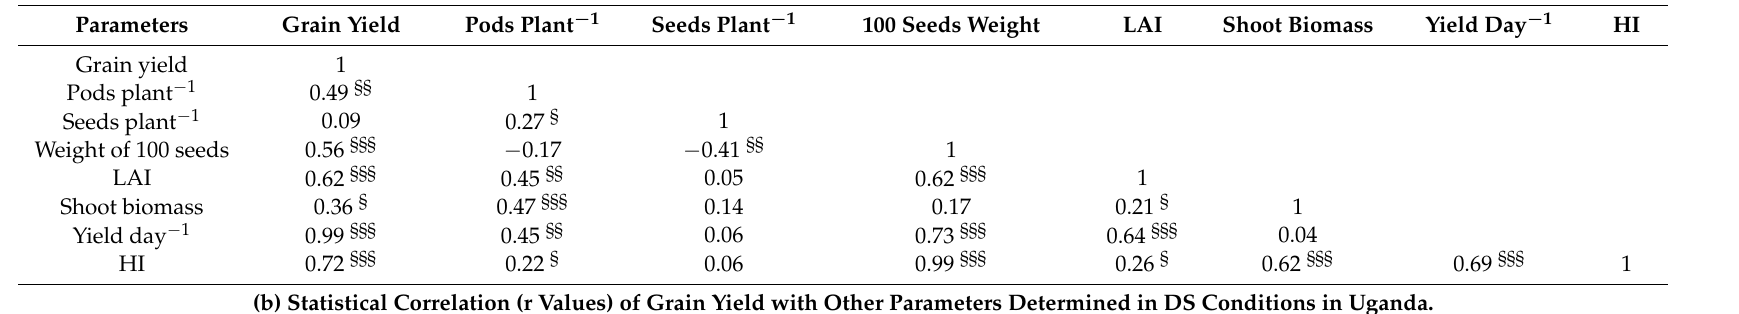
(b) Statistical Correlation (r Values) of Grain Yield with Other Parameters Determined in DS Conditions in